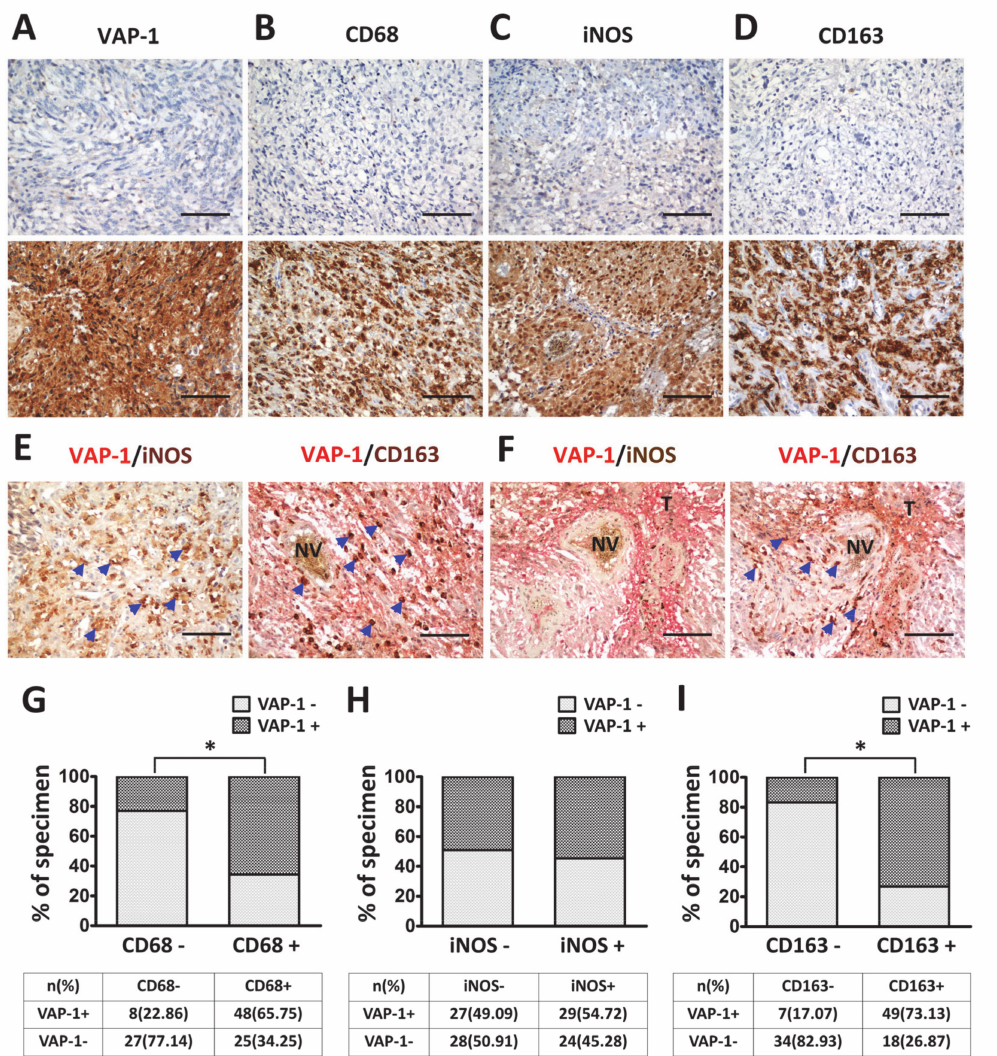
Figure 2. Representative immunostaining for expressions of VAP-1 and TAM-related proteins in gliomas. ( A ) Immunoreactivity of VAP-1: Top panel, negative in tumor cells as determined from staining in the cytoplasm; Bottom panel, positive staining. Immunoreactivity of TAM identifier, CD68 ( B ), iNOS ( C ), and CD163 ( D ) revealed nuclear and cytoplasmic staining in gliomas, which indicated tumor immune activity. ( E , F ) Double-staining immunohistochemistry of VAP-1(red color, cytoplasmic staining) in combination with iNOS + M1 or CD163 + M2 (brown color, nuclear staining) showed two TAM subtypes presented at di ff erent levels of VAP-1 from glioma milieu. Blue arrows indicate the iNOS + or CD163 + macrophages in tumor tissues. Immunoreactivity percentage of VAP-1 co-expressed with CD68 ( G ), iNOS ( H ), and CD163 ( I ) phenotypes were observed in lesions. Low VAP-1 expression is depicted as light gray columns, whereas high VAP-1 expression is shown as dark gray columns. Chi-square test was used for statistical analysis. (Original magnification: × 200). Abbreviations: VAP-1: vascular adhesion protein-1; TAM: tumor associated macrophage; iNOS: inducible nitric oxide synthase; T, tumor tissue; NV, neovasculature. p < 0.05 was considered statistically